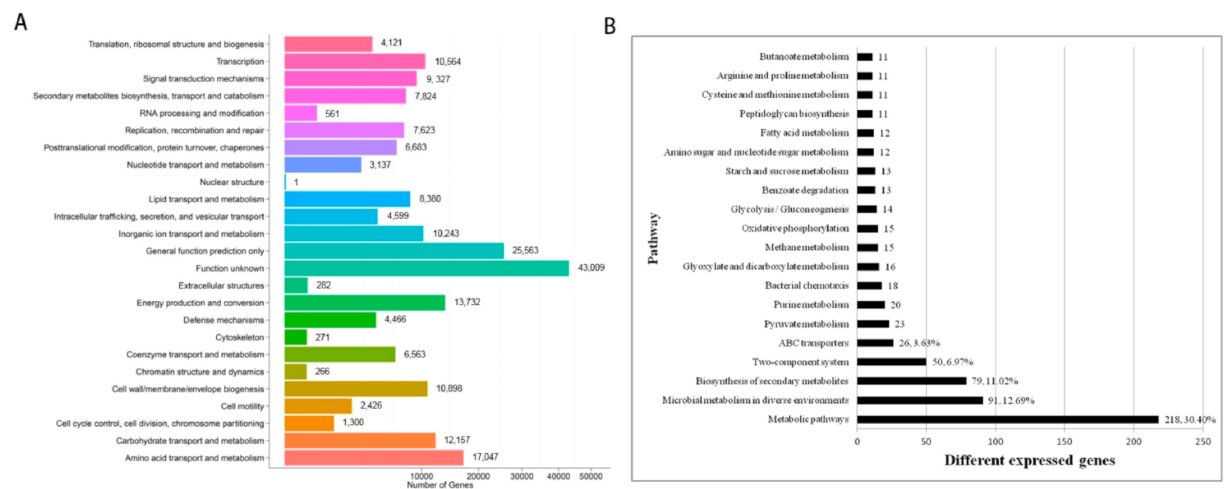
Figure 4. Sequence and functional analysis of macro factors in rhizosphere microbiome. ( A ). The functional classification of genes from citrus rhizosphere metagenome based on eggNOG database. ( B ). The top 20 pathways of KEGG functional classification of the genes with different abundance between healthy and CLas-infected citrus rhizosphere